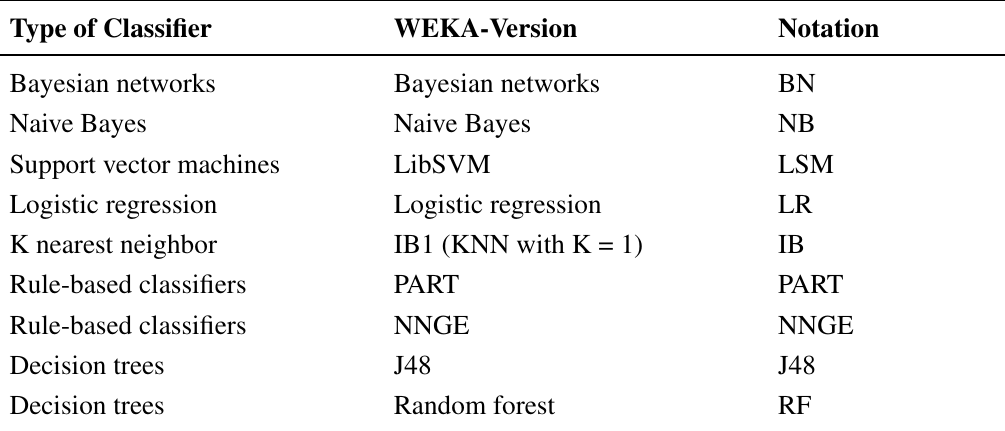
Table 3. Classification